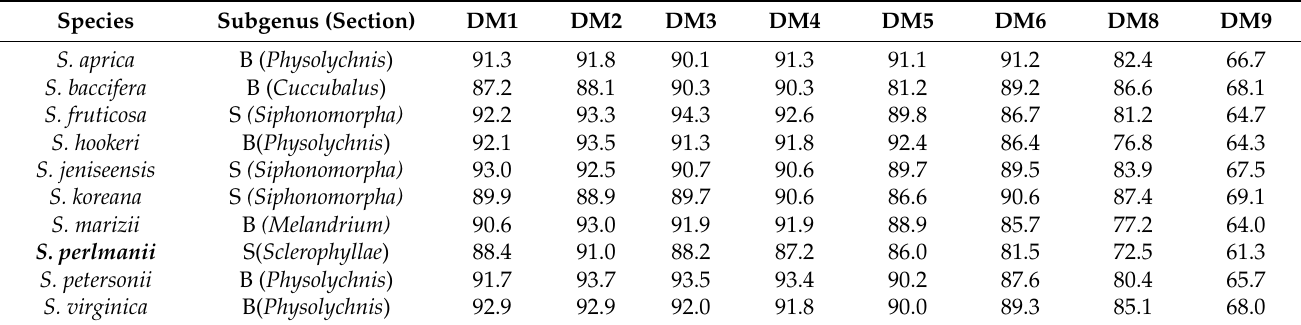
Table A4. Values of J index for the average silhouettes of each species with seven dorsal models: species reaching maximum in convex models DM1, DM2, DM3, or DM4. In bold: species that did not reach the threshold value of 89.0 for the J index estimated as the mean of 20 seeds. B: corresponds to S . subg. Behenantha ; S: corresponds to S . subg. Silene .